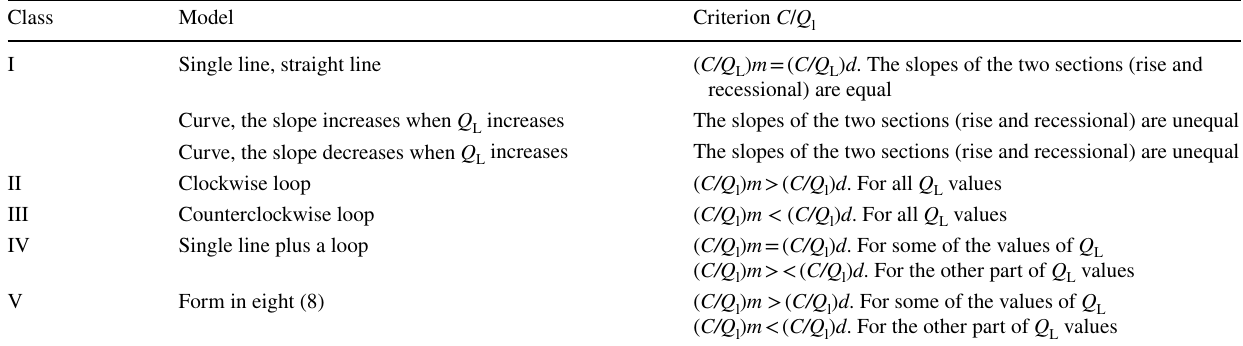
Table 2 Classes of C – Q l relations (Williams